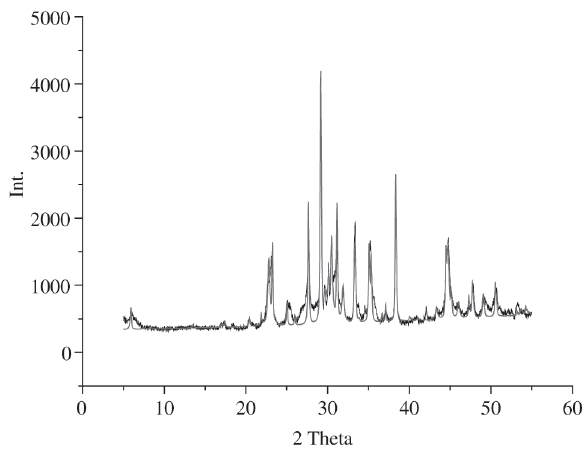
Figure 4. Difractogram of the bulk Bi by the Rietveld method. The black line is the experimental diffrac- tion profile; the red is the calculated one, based at the classical Rietveld model for background intensity